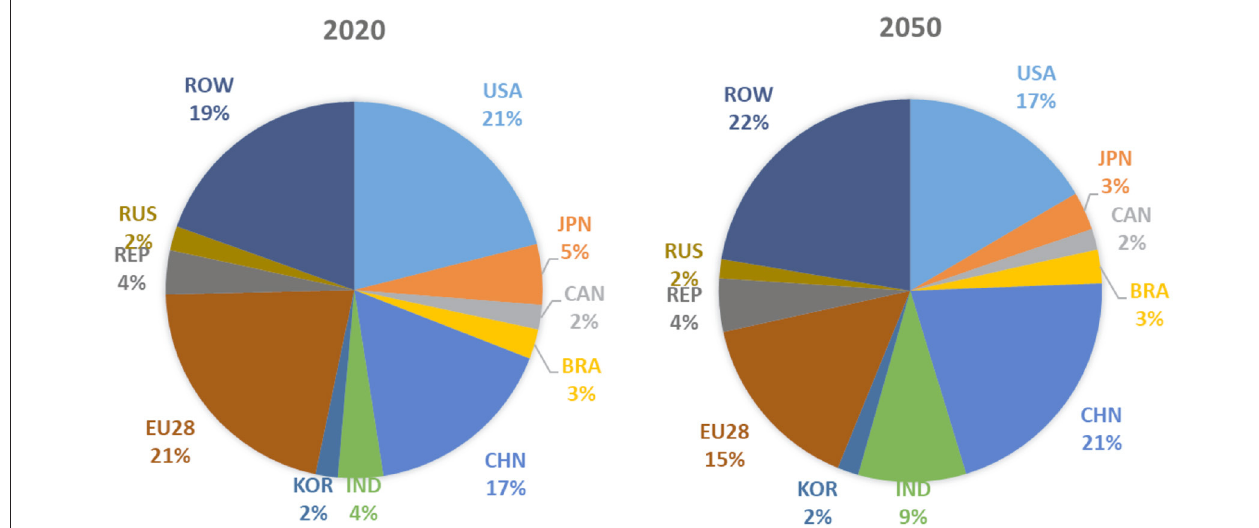
FIGURE 3 | Share of major economies in global GDP in 2020 and in 2050.